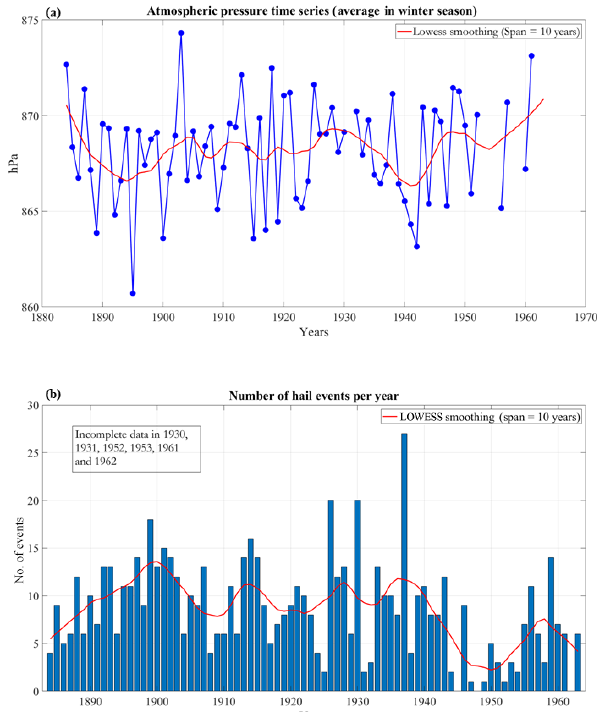
Figure 10. Panel (a) : time series (blue line) of winter atmospheric pressure from 1884 to 1963. Each value (blue dot) is the average of the sub-daily observations measured during January, February and March. The red curve is the LOWESS filter, computed using a 10-year span. Panel (b) : time series (vertical blue bar) of yearly hail events at MVOBS from 1884 to 1963. The hail occurrence has been computed for every year of the investigated period using the sub-daily observations of precipitation type. The red curve is the LOWESS filter, computed using a 10-year span. It should be noted that such data were subject to a quality control procedure that did not include the